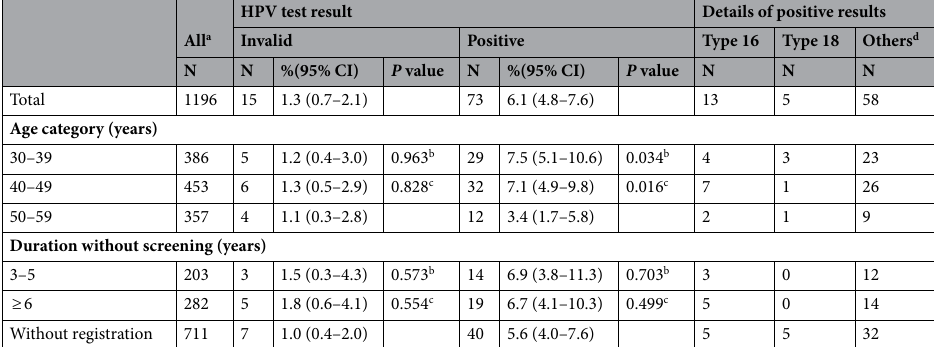
and obtained valid negative results for HPV. The time-to-event results are shown in Table 4 and Supplementary Fig. S1. It took only 9 days for half of the participants to order the test and 89 days for 90% of them, whereas it took a relatively long time for participants to return the samples after receiving the kit; it took 35 days for half of them and 133 days for 90% of them. The period between collecting a sample and returning it was quite short. Of 1,194 participants who returned a sample and declared the sample collection date, 9 (0.75%) participants were outside of the recommendation, meaning